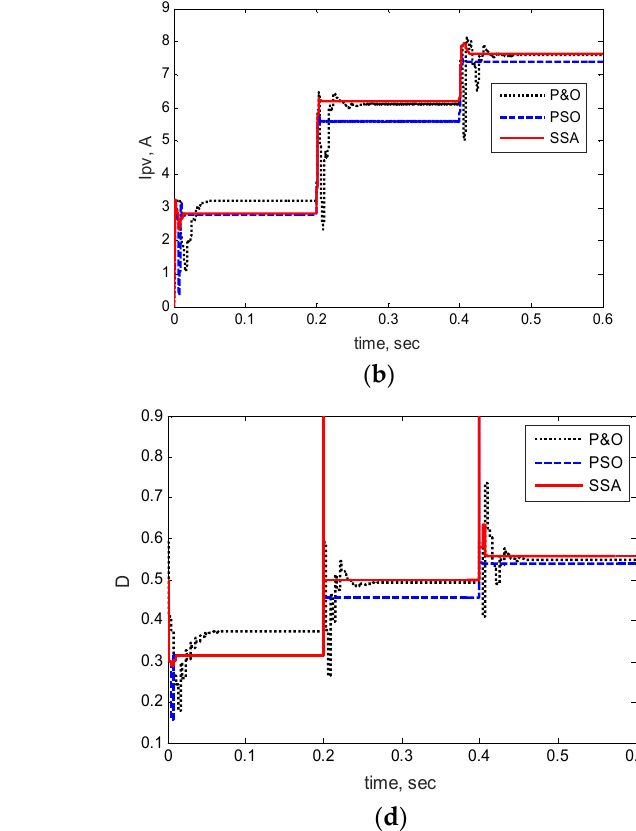
Figure 9. Photovoltaic panel tracking curves using the proposed method and the P&O and PSO methods in variable temperature conditions: ( a ) Vpv, ( b ) Ipv, ( c ) Ppv, ( d ) duty cycle.